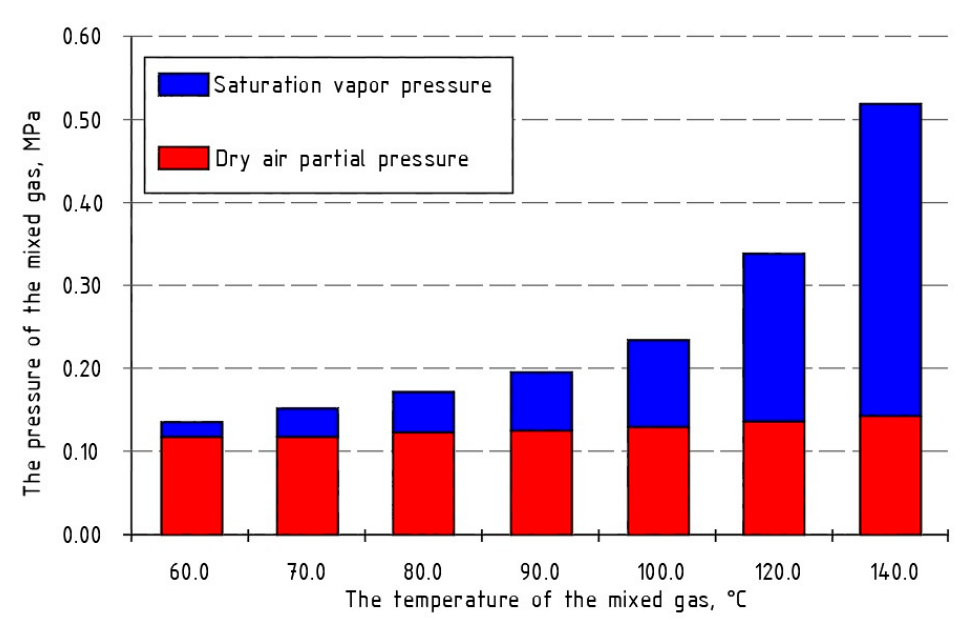
Figure 5. The effect of temperature on the saturation vapor pressure and dry air partial pressure. Figure 5. The e ff ect of temperature on the saturation vapor pressure and dry air partial